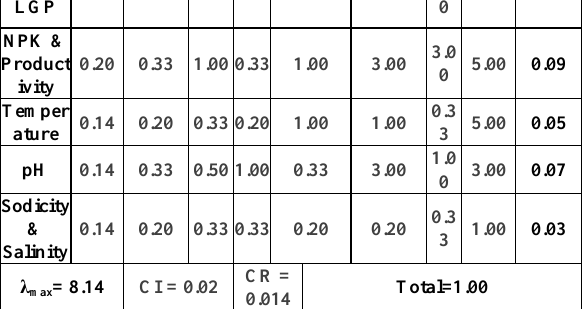
Table 6. Pairwise comparison matrix of selected criteria’s and their weights for